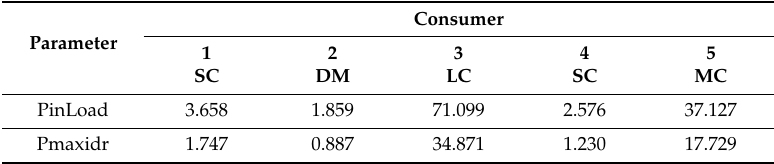
Table 6. Characteristics from new